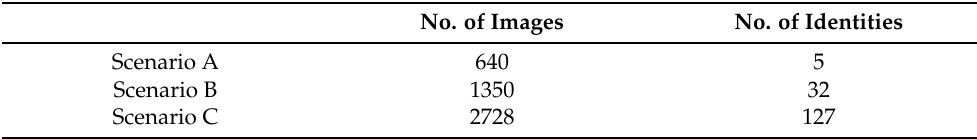
Table 8. Size of testing subsets on LFW for face recognition.